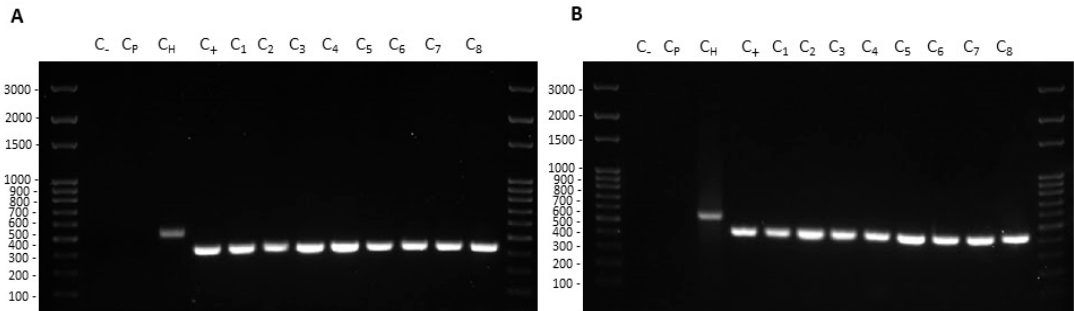
Figure 5. Colony-PCR from recipient cells treated with K. pneumoniae -pGR ( A ) and K. pneumoniae -PRM ( B ) OMVs. DNA gel showed PCR products with expected lengths: ß-lactamase product~424 bp (C 1–8 ), ribosomal 16S product~550 bp (C H ). Control water (C − ) and untreated bacteria (C p ) did not show amplification.